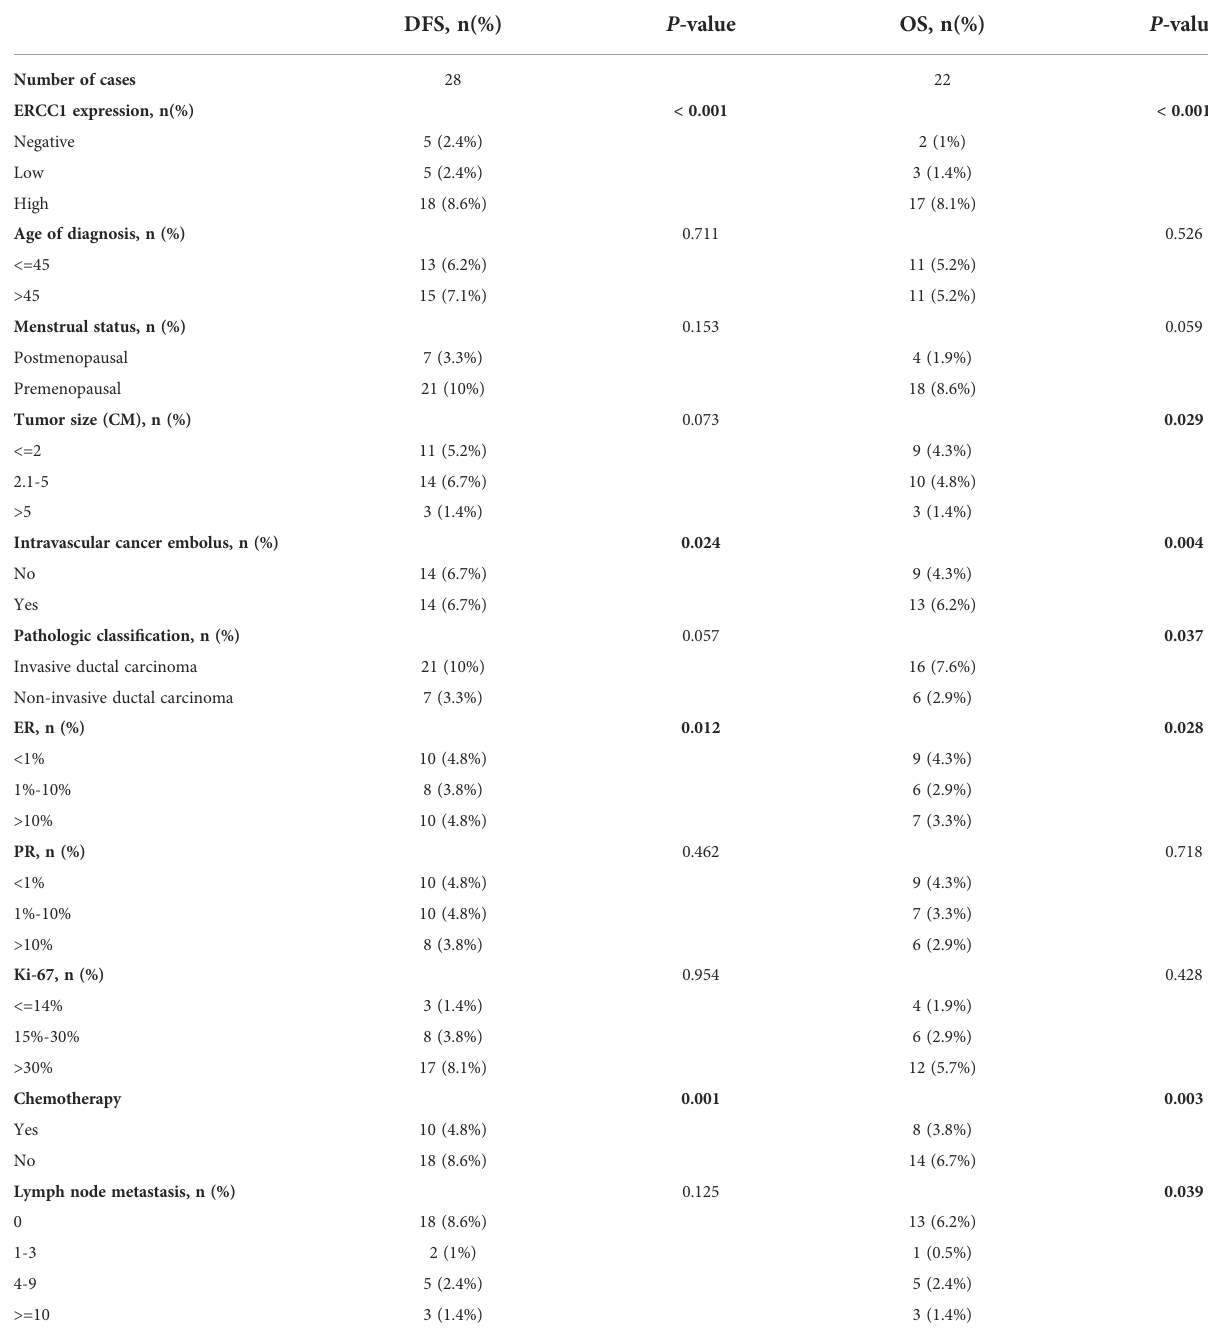
TABLE 3 Univariate analysis of DFS and OS in the collection of 210